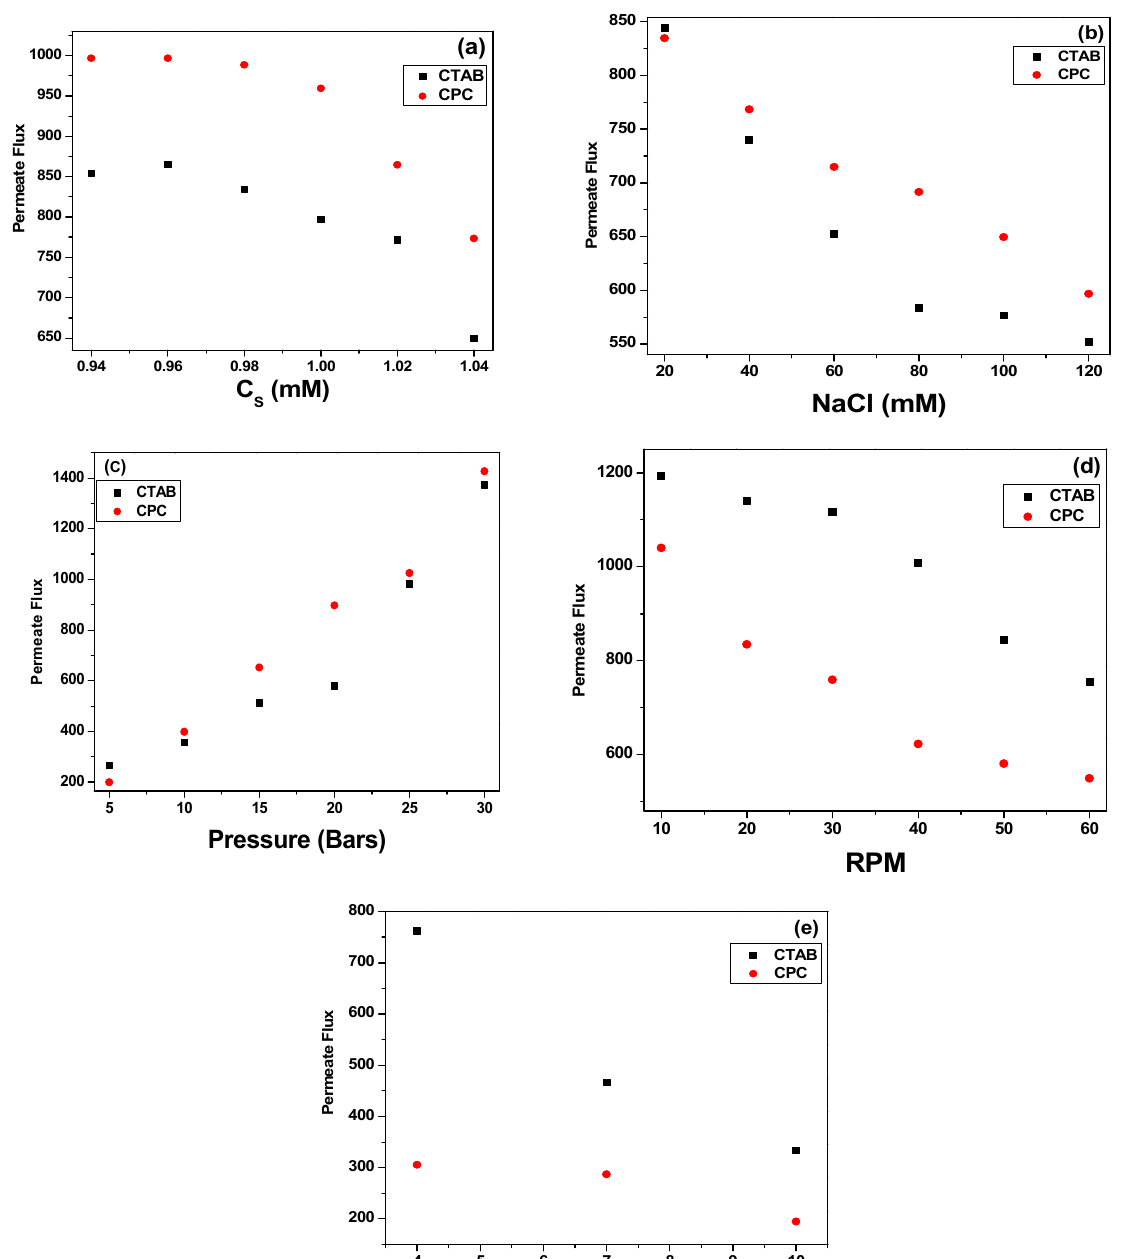
Figure 5. Permeate flux (J) for the effect of ( a ) surfactant concentration (C S ), ( b ) electrolyte concentration (NaCl), ( c ) transmembrane pressure, and ( d ) RPM, ( e ) pH.